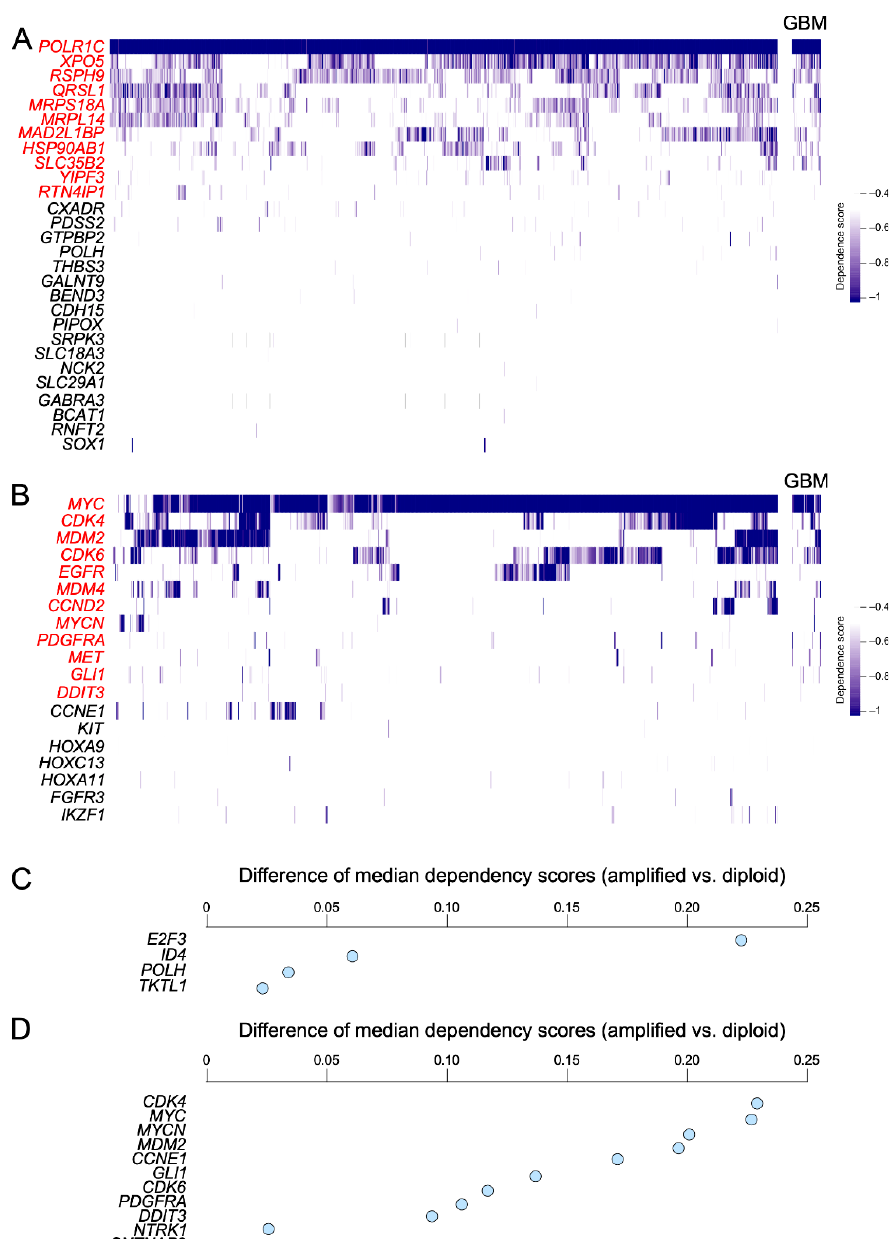
Figure 5. Validation of CiberAMP-identified SCNV-DEGs. ( A ) Effect of knockout of indicated genes related to SCNV-DEGs found in glioblastoma on the proliferation of cancer cell lines. In the right column (GBM), we specifically include genes whose knockout affects the proliferation of at least one glioblastoma cell line. The effect of proliferation is depicted as a blue gradient (see the scale on the right). Genes are shown on the left. In red, those that affect proliferation in at least one of the glioblastoma cell lines contained in the screening. Cell lines are shown in vertical lines (we have omitted the name of these lines for the sake of space). ( B ) Effect of the knockout of the indicated glioblastoma SCNV-DEGs harboring known cancer driver genes on the proliferation of cancer cell lines. Depiction of cell lines and proliferative effect of the gene knockout is shown as in ( A ). ( C ) Effect of knockout of the indicated genes linked to SCNV-DEGs found in glioblastoma on the proliferation of cancer cell lines that are positive for that SCNV. Depiction of cell lines and proliferative effect of the gene knockout is shown as in ( A ). ( D ) Effect of knockout of the indicated glioblastoma SCNV-DEGs harboring known cancer driver genes on the proliferation of cancer cell lines that are positive for that specific SCNV. Depiction of cell lines and proliferative effect of the gene knockout is shown as in ( A